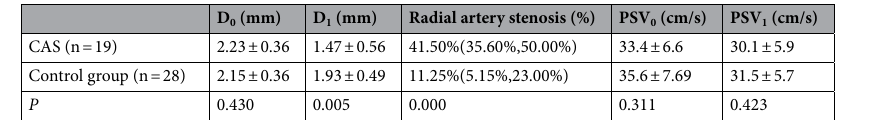
Table 2. The results of ergonovine provocation test of radial artery in the two groups. The degree of radial artery stenosis is expressed as P50 (P25-P75). CAS: coronary artery spasm; D 0 : inner diameter of the radial artery before ergonovine provocation; D 1 : inner diameter of the radial artery after ergonovine provocation; PSV 0 : peak systolic velocities of the radial artery before ergonovine provocation and PSV 1 : peak systolic velocities of the radial artery after ergonovine